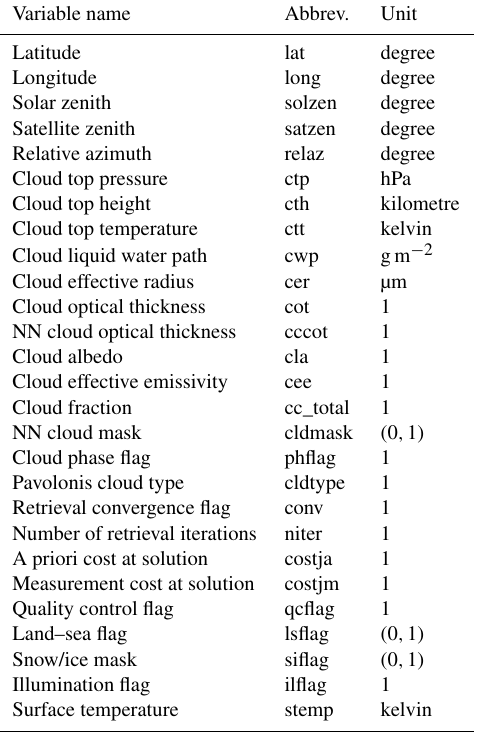
Table A2. CC4CL L2 primary output variables. NN is neural